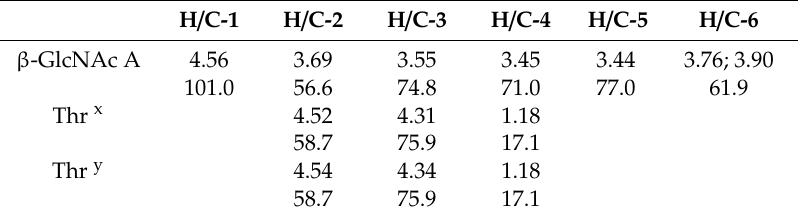
Table 3. Purified SML10 glycopeptide reaction product analysis. NMR data (600 mHz, 25 °C)